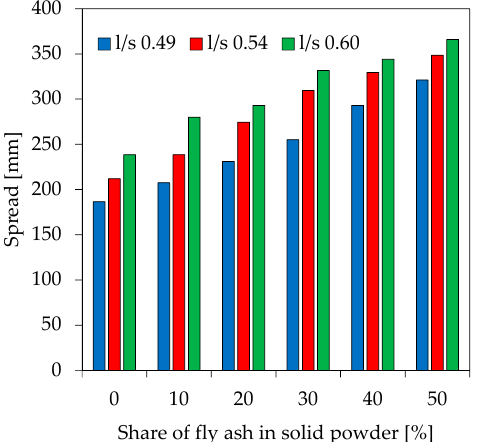
Figure 3. Spread of fresh geopolymer paste.